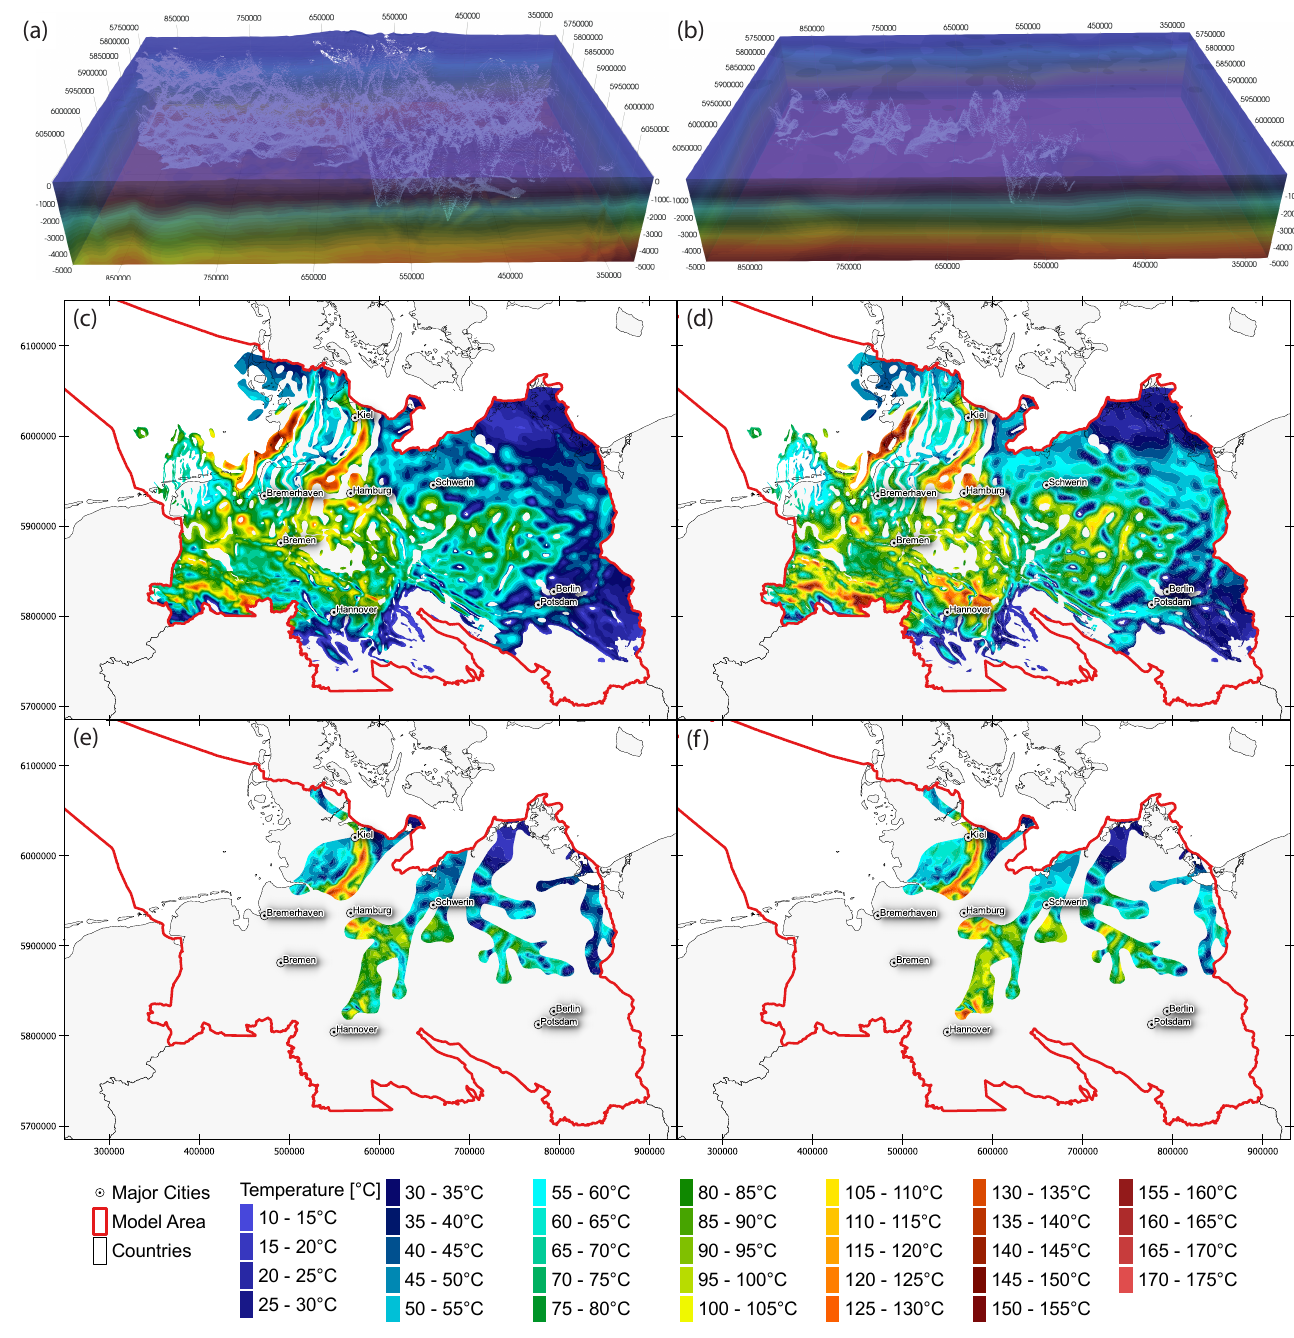
Figure 3. ( a ) 3D temperature distribution as derived from the 3D CEBS model [32]. Color-coding indicated at bottom. Inside the semi-transparent block, the reservoir mid of the Upper Keuper layer from the TUNB model [31] is envisaged; ( b ) 3D temperature distribution as derived from the Fachinformationssystem Geophysik [46]. Same color-coding as in ( a ), inside the transparent cube, the reservoir mid of the Upper Exter formation is envisaged; ( c , d ) Extracted temperature distribution (resampled with dataset filter of paraview [49]) for the Upper Keuper layer from ( c ) CEBS dataset and ( d ) GeotIS dataset; ( e ) Extracted temperature of the Upper Exter formation for ( e ) CEBS dataset and ( f ) GeotIS dataset; ( a – f ) Coordinates are in UTM Zone